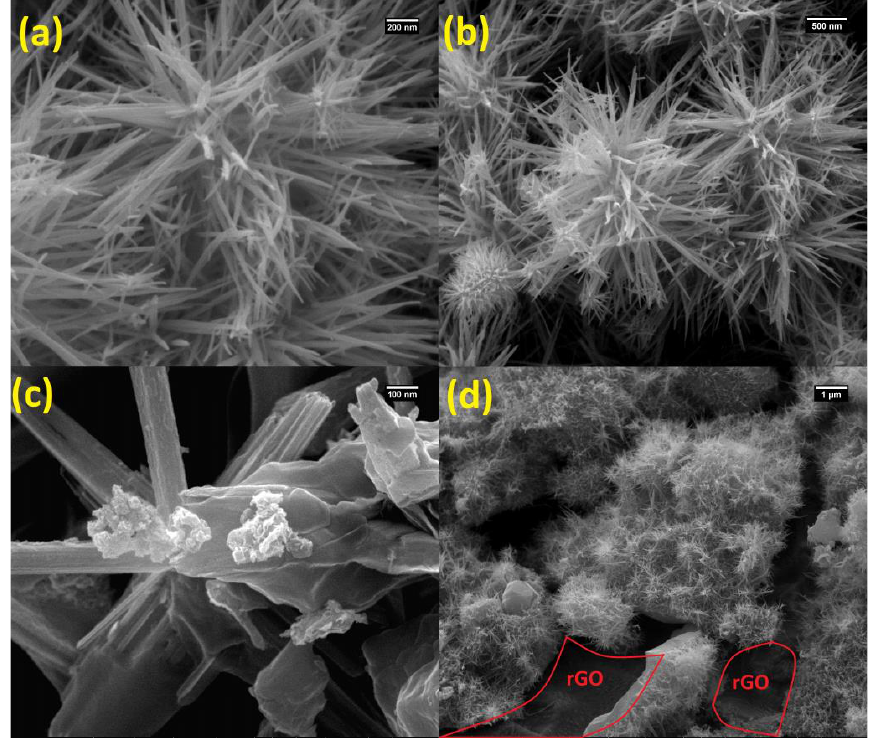
Figure 2. SEM images of MN ( a , b ) and MNR ( c , d ). The EDX mapping analysis is an appropriate way to investigate the presence of manganese, nickel, cobalt, and oxygen. In this system, the number of X-rays emitted is counted against their energy. The amount of energy of each X-ray determines the characteristic of the element from which the beam is emitted. Therefore, by obtaining the energy spectrum against the counted X-rays, the quantitative and qualitative estimates of the elements in the sample are examined. Figure 3 also shows the EDX diagram, which confirms the presence of the elements Mn, Co, O, and Ni on the nickel foam